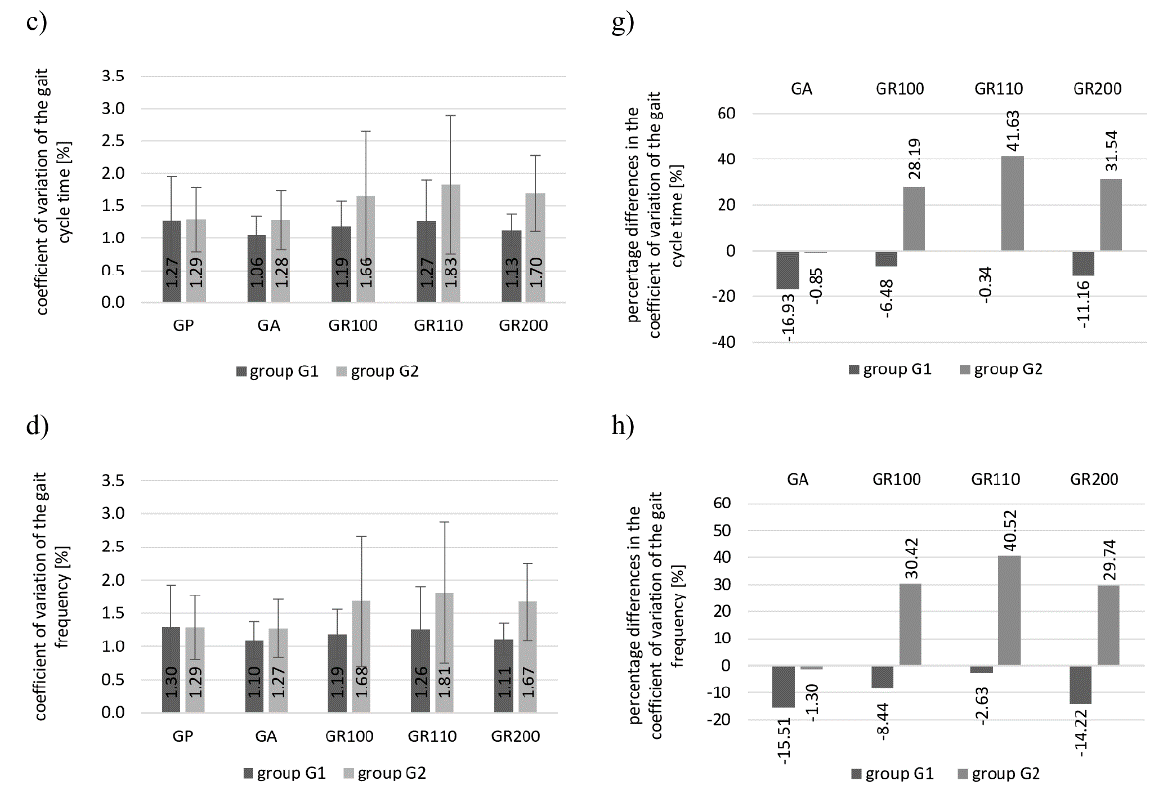
Figure 2. Coefficient of variation and percentage differences in the coefficient of variation for groups G1 and G2 obtained in particular tests for the analyzed parameters of gait: ( a , e ) length of the gait cycle; ( b , f ) stride width; ( c , g ) time of the gait cycle; ( d , h ) frequency of taking steps. (CV—coefficient of variation, G1—group 1, G2—group 2, RAS—rhythmic auditory stimulation, GP—reference gait test without auditory stimuli, GA—gait test with arrhythmic stimulus, GR100—gait test with rhythmic stimulus played at a rate corresponding to the frequency of gait, GR110—gait test with rhythmic stimulus played at a rate corresponding to gait frequency increased by 10%, GR200—gait test with rhythmic stimulus played at a rate corresponding to doubled gait frequency).